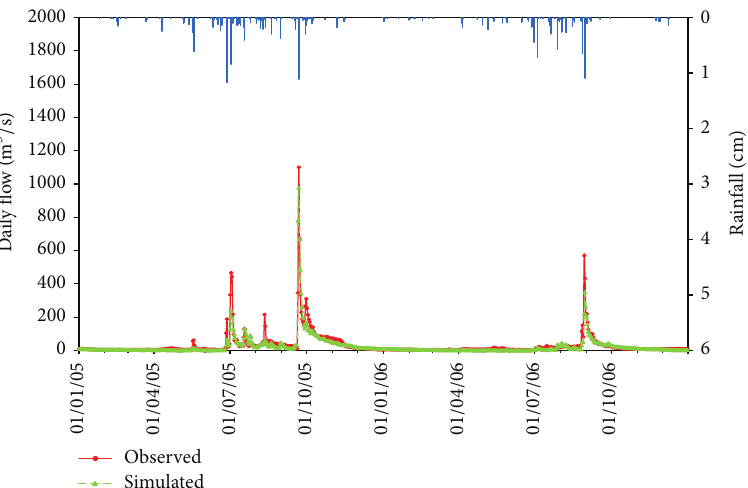
Figure 6: Comparison of observed and simulated results for daily rainfall-runoff simulation in Jiaoyi watershed during validation period (2005 ∼